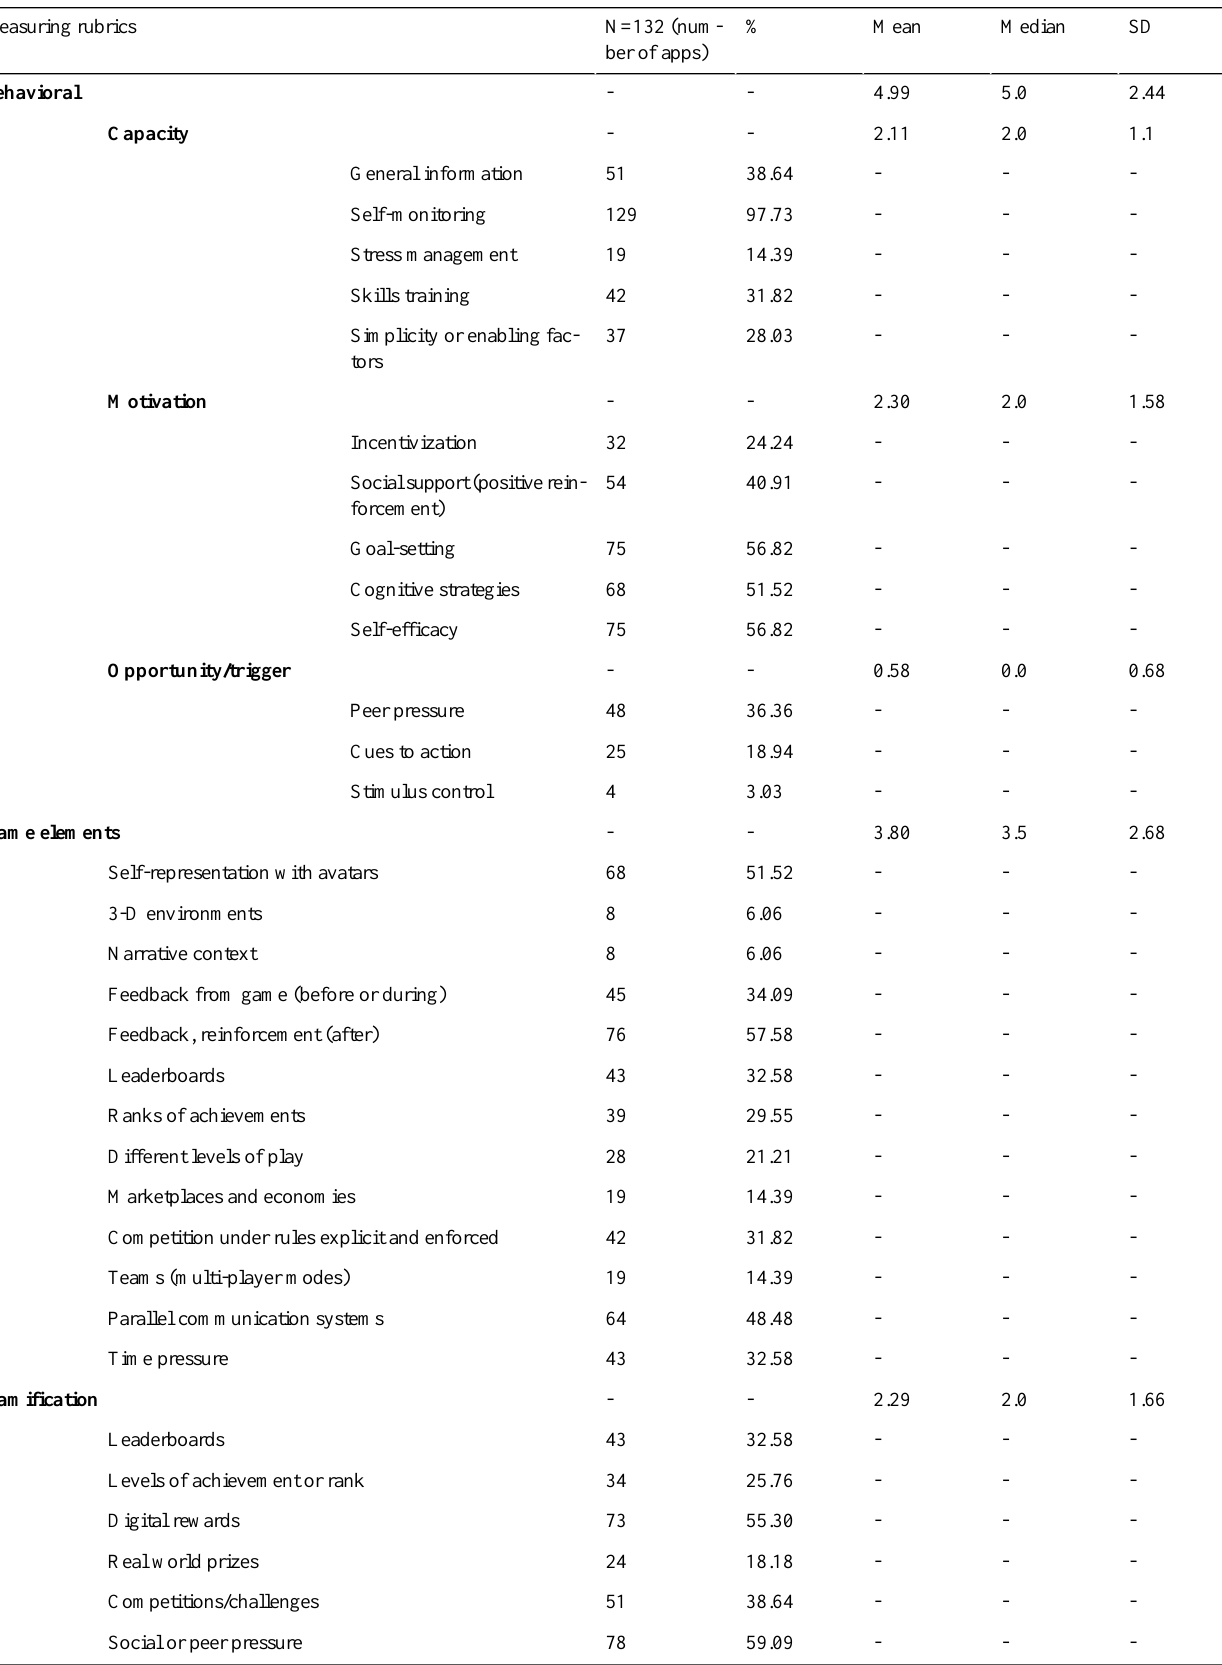
Table 3. Descriptive statistics for evaluation rubrics